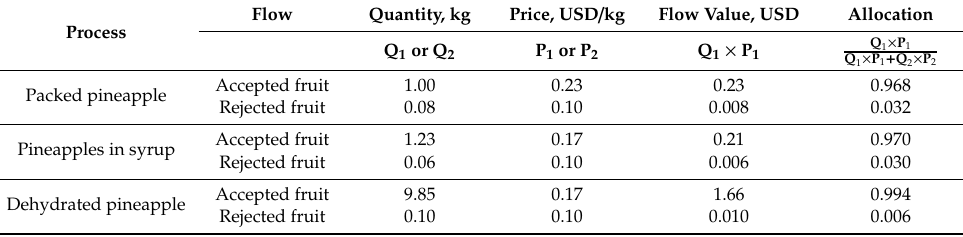
Table 4. Economic allocation applied to pineapple inflows to processing stages.